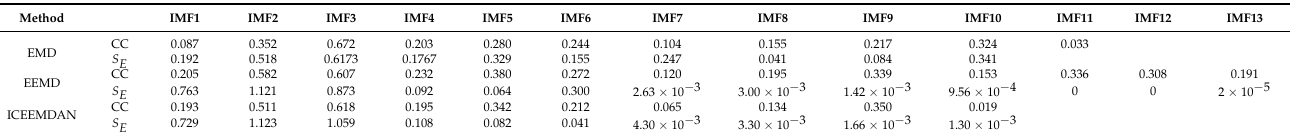
Table 1. Sample entropy and correlation coefficient.